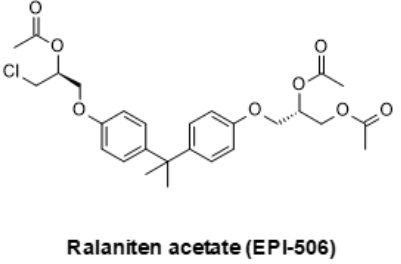
Figure 4. The AR-V7 inhibitor EPI-506.